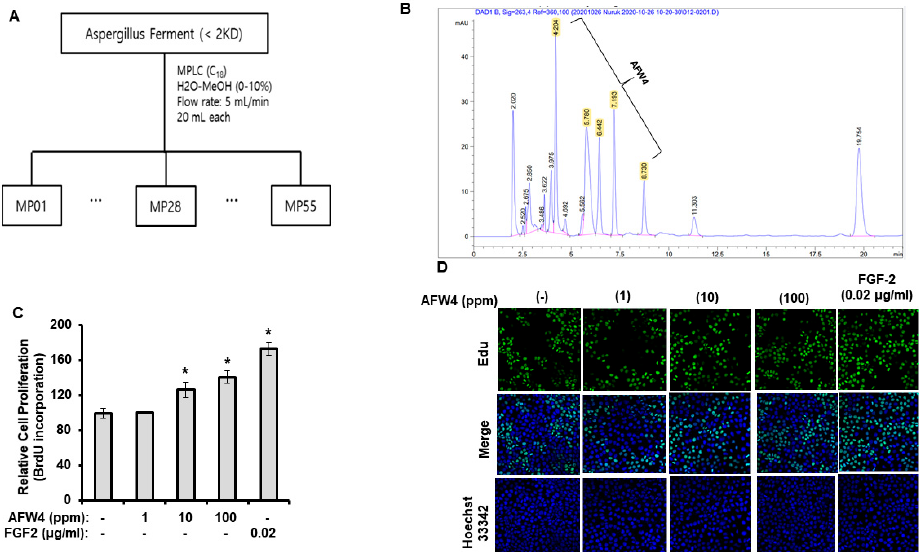
Figure 3. A Wheat peptone fraction of 2 kDa or less (AFW4) promotes cell proliferation potential.